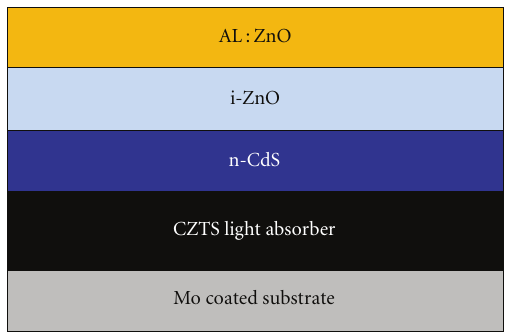
Figure 3: Schematics of the structure of CZTS solar